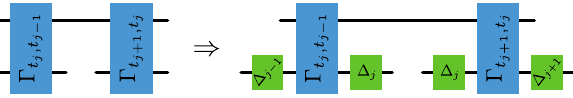
FIG. 9. Transformation to NDGD dilation. Any dilation of an open dynamics can be mapped onto a NDGD one by inserting completely dephasing maps on the level of the system. If the process is classical, then the transformed dilation yields the same statistics as the original one when probed in the classical